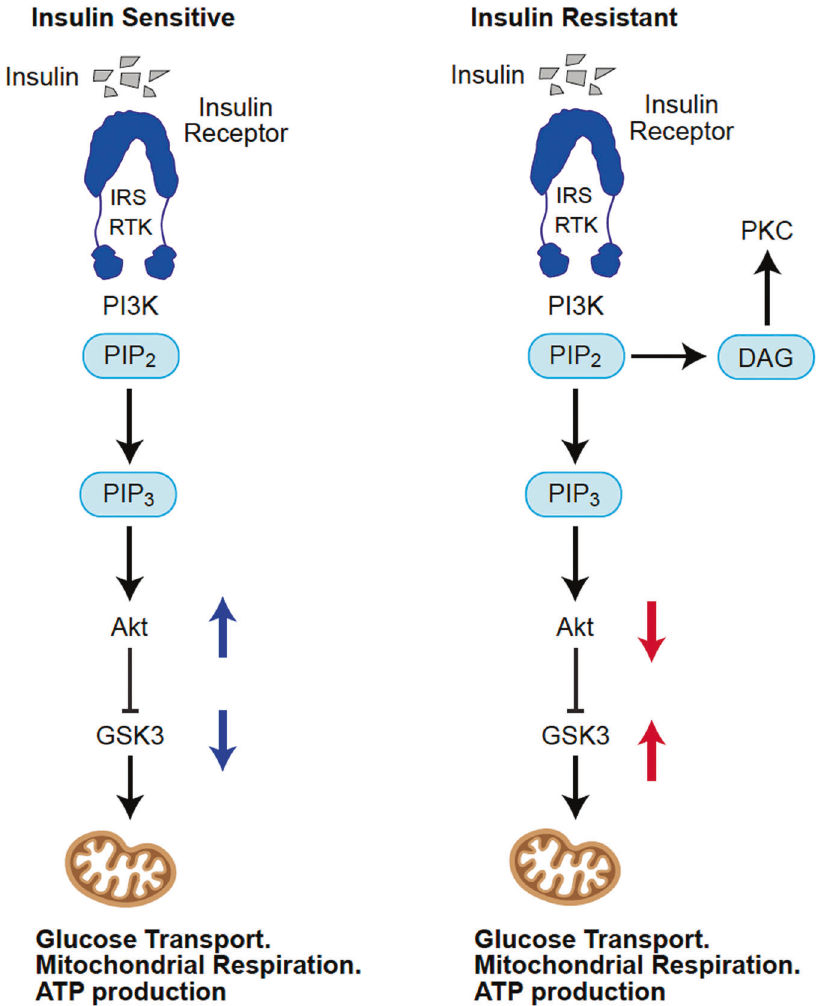
Fig. 2 In the insulin-sensitive cell, activation of the PI3K/Akt insulin signaling pathway activates Akt which in turn phosphorylates GSK3 causing transient inhibition. Inhibition of GSK3 serves as a signal to activate downstream metabolic effects such as GLUT 4 mediated glucose uptake, glycogen synthesis, and mitochondrial respiration. In contrast, in the insulin-resistant cell PIP2 is cleaved to form DAG, activating PKC which phosphorylates and inhibits the insulin receptor. This inhibition of insulin signaling leaves GSK3 in a state of chronic overactivity with resultant deleterious effects on glucose metabolism and mitochondrial respiration. PI3K phosphatidylinositol 3-kinase, PIP2 phosphatidy- linositol 4,5 bisphosphonate, PIP3 phosphatidylinositol 3,4,5 triphosphate, Akt protein Kinase B, GSK3 glycogen synthase